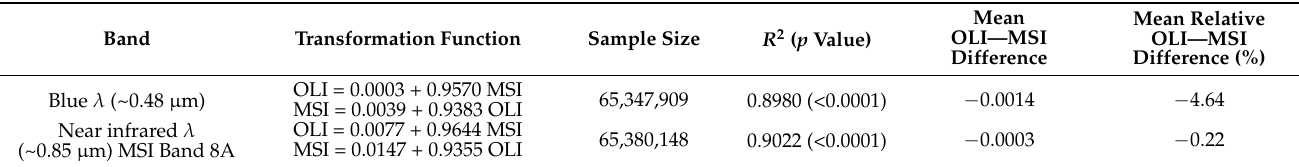
Table 3. Transformation functions between the Sentinel-2 MSI and Landsat-8 OLI developed through OLS regression (Zhang et al. [36]). Band Transformation Function Sample